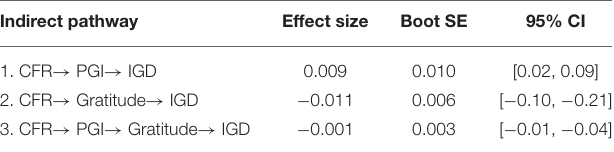
TABLE 3 | Test results of indirect